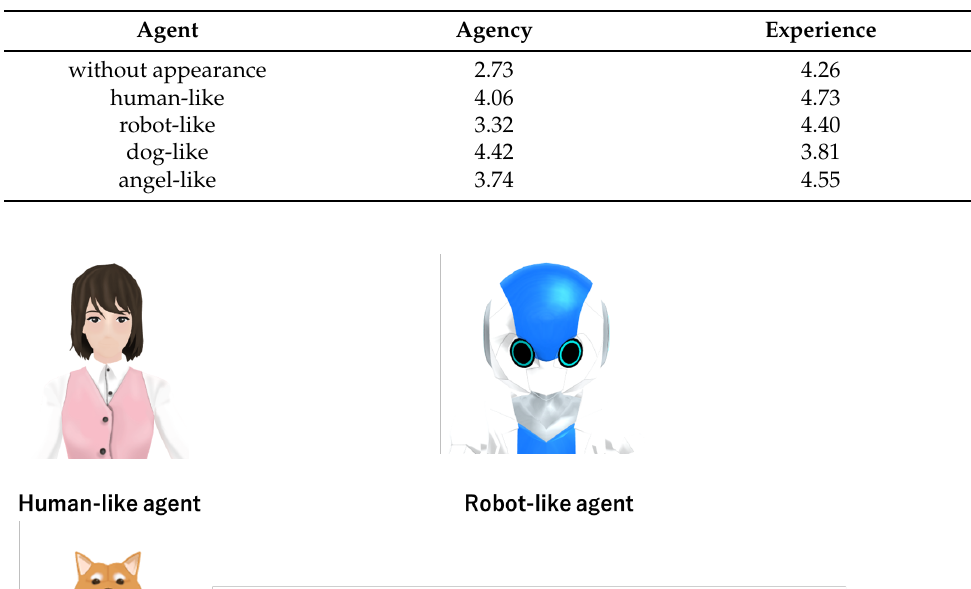
Table 2. Perceived agency and experience for each agent.